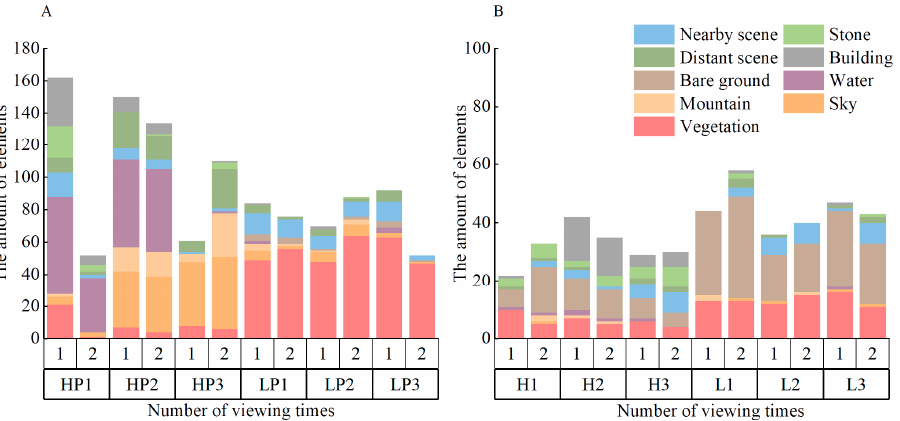
Figure 9. Statistics of all participants’ likes and dislikes for forest landscapes. ( A ) Statistics of likes for landscape elements; ( B ) Statistics of dislikes for landscape elements; the analysis and graphics software are Origin Pro 2021 v9.8.0.200. This figure was created by the author.